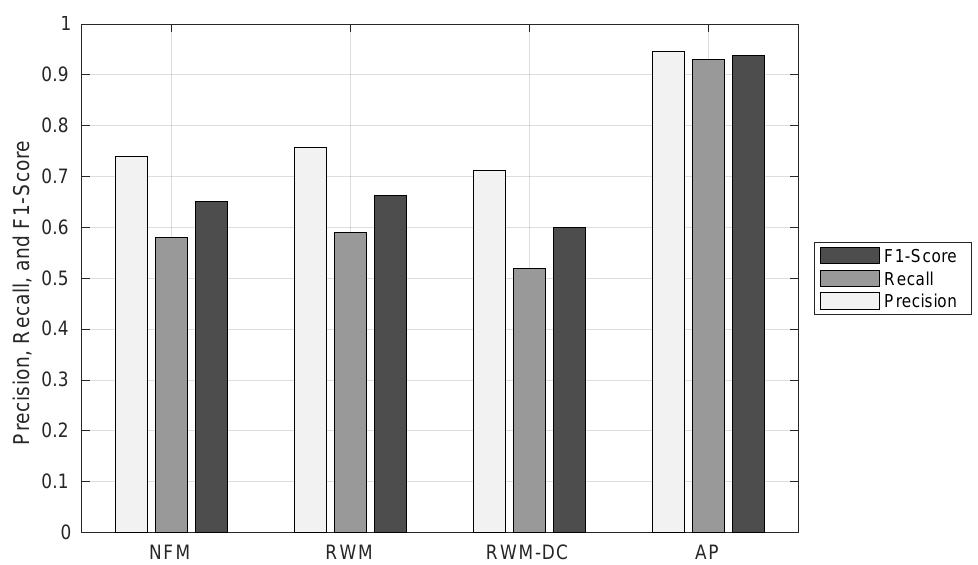
Figure 16. Ratio of edge matching results.